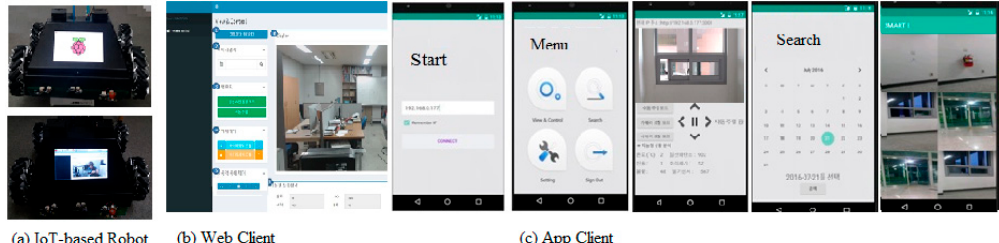
Figure 7. Graphical user interface of IoT platform with an intelligent monitoring robot. ( a ) IoT-based robot; ( b ) Web Client; ( c ) App Client